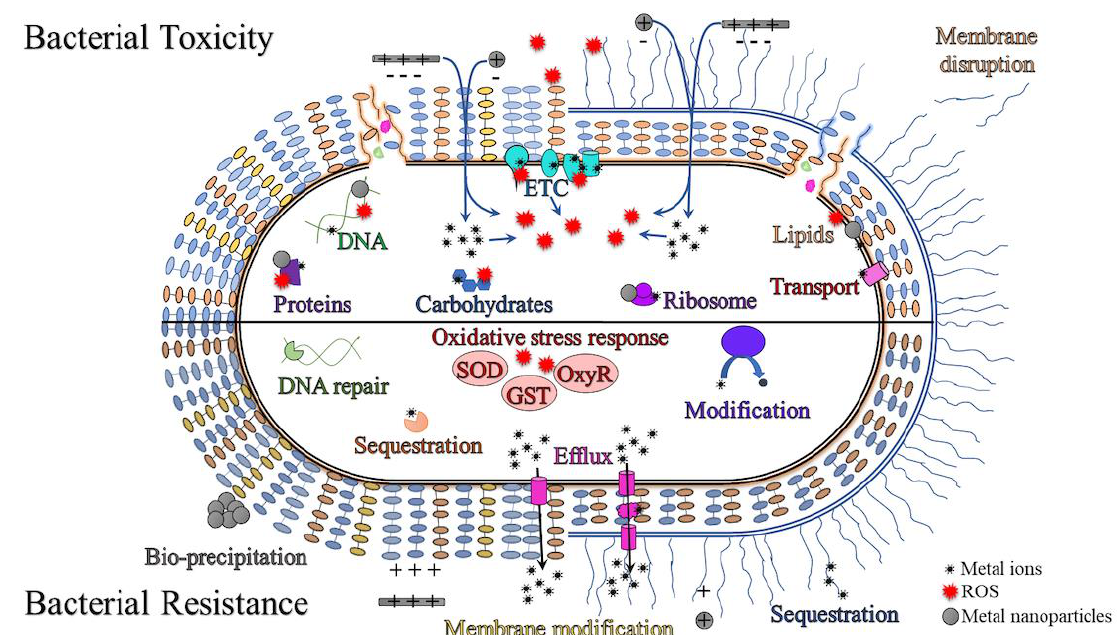
Figure 1. Summary of cellular targets ( top ) for metal and metal oxide nanoparticles and corresponding bacterial resistance mechanisms ( bottom ) in both Gram-positive ( left ) and Gram-negative ( right ) species. Before entry metal nanoparticles may produce reactive oxygen species (ROS), induce membrane fluidity and release metal ions [90]. Once inside the cell metal ions, nanoparticles or ROS may target the electron transport chain, ribosomes, DNA, proteins, lipids, carbohydrates and transport systems [90]. Bacteria respond by activating oxidative stress response proteins, DNA repair systems and metal efflux pumps [18,110,112]. Membrane modifications including an increase in flagellin, exopolysaccharides and changes to lipid composition can prevent metal entry by reducing electrostatic interactions and sequestering metal ions [18]. More resistant bacteria have also developed ways to modify metals into less toxic forms through reduction and/or bio-precipitation and nanoparticle aggregation [18,112,113].